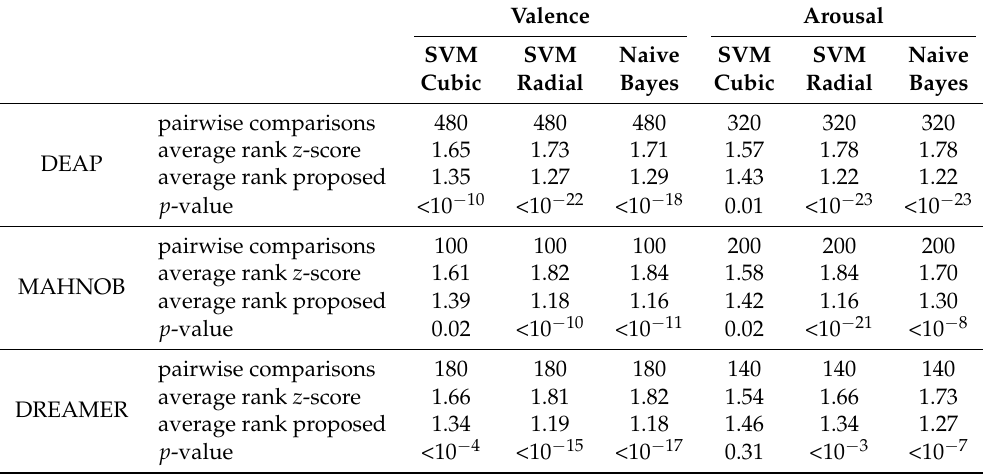
Table 4. Results of Friedman test on data reported in Table